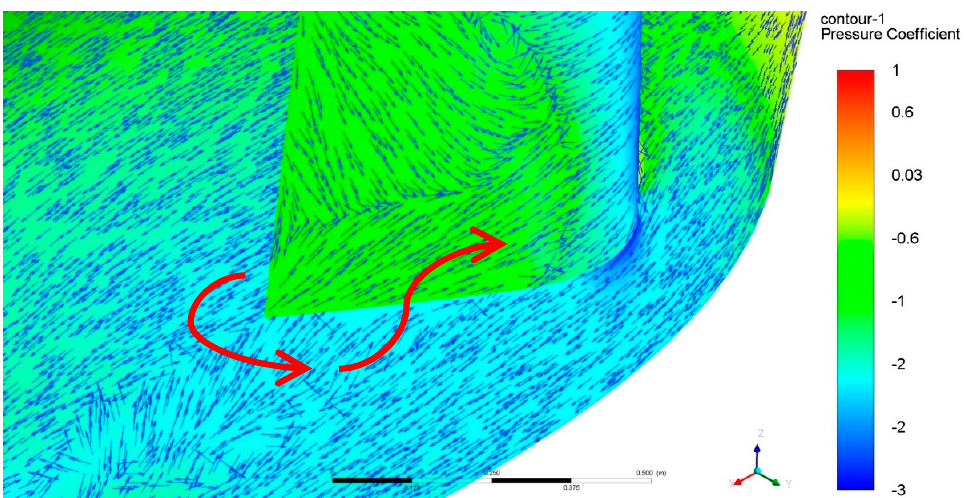
Figure 8. Front wing–body junction area flow field visualization and directions of reverse flow from beneath the wing to the fuselage and into the wing upper surface.